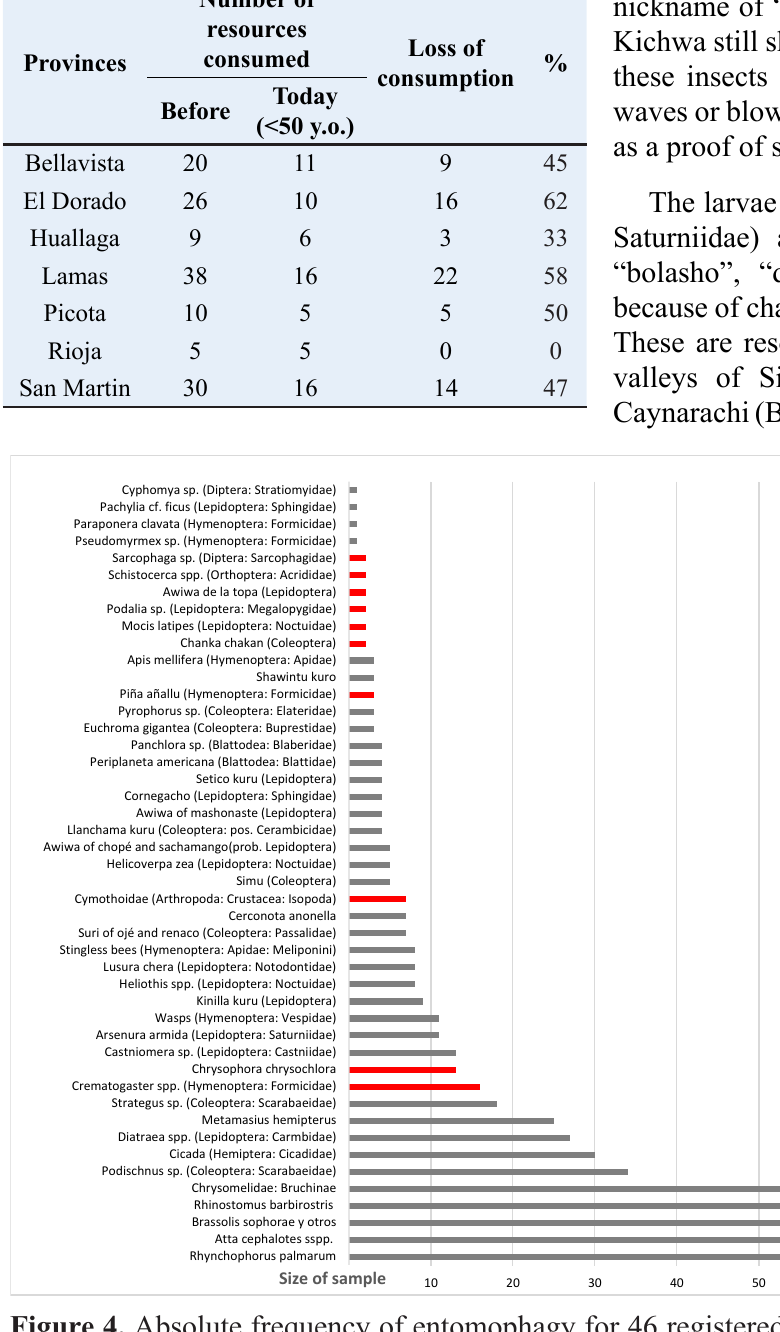
Figure 4. Absolute frequency of entomophagy for 46 registered resources. Red bars indicate the resources which consumption has been discontinues at the